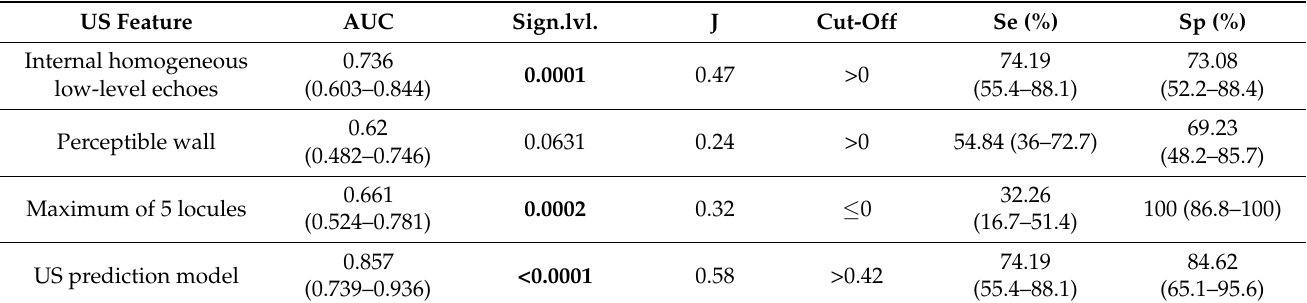
Table 3. The receiver operating characteristic analysis results of the prediction model and the ultrasound parameters that were independently associated with endometriomas.